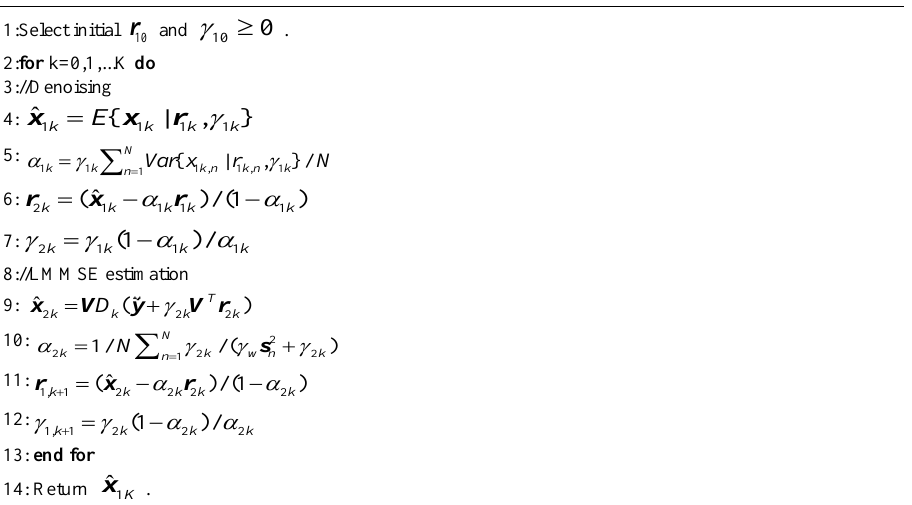
Algorithm 2 summarizes the symbol detection algorithm based on VAMP in SC-FDE system. the complexity of VAMP is dominated by two matrix-vector multiplies per iteration in nine